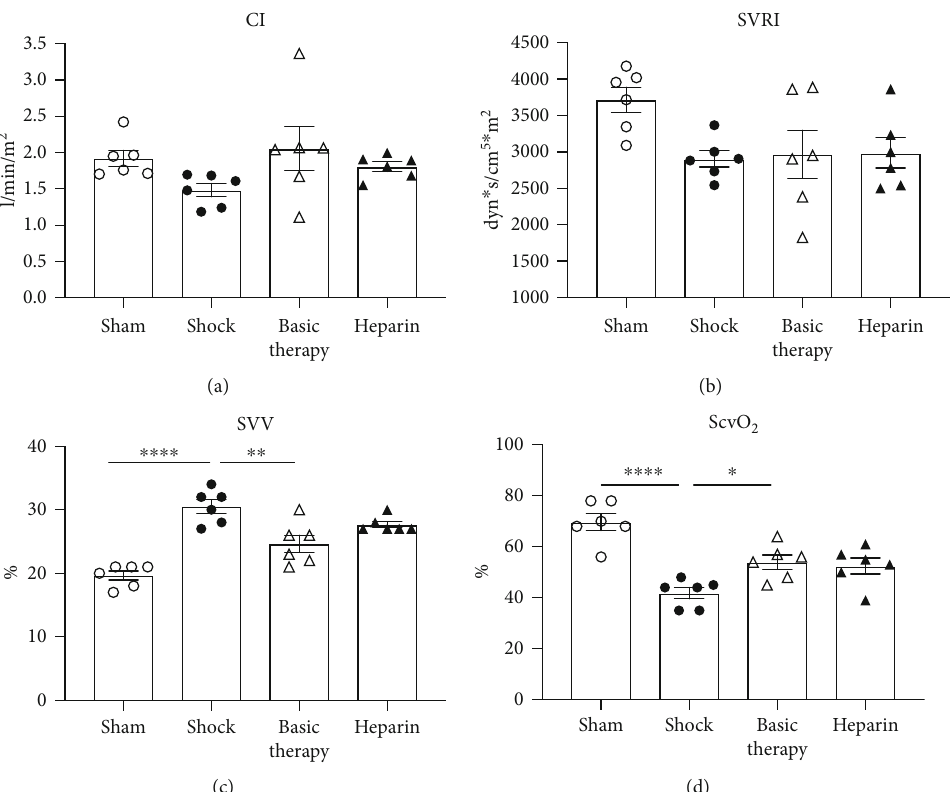
Figure 6: The e ff ect of UFH on systemic hemodynamic variables in septic shock. (a – c) Cardiac index (CI), systemic vascular resistance index (SVRI), and stroke volume variation (SVV) were acquired from PICCO. (d) Central venous oxygen saturation (ScvO blood gas analysis. ∗ P < 0 : 05 ; ∗∗ P < 0 : 01 ; ∗∗∗∗ P < 0 : 0001